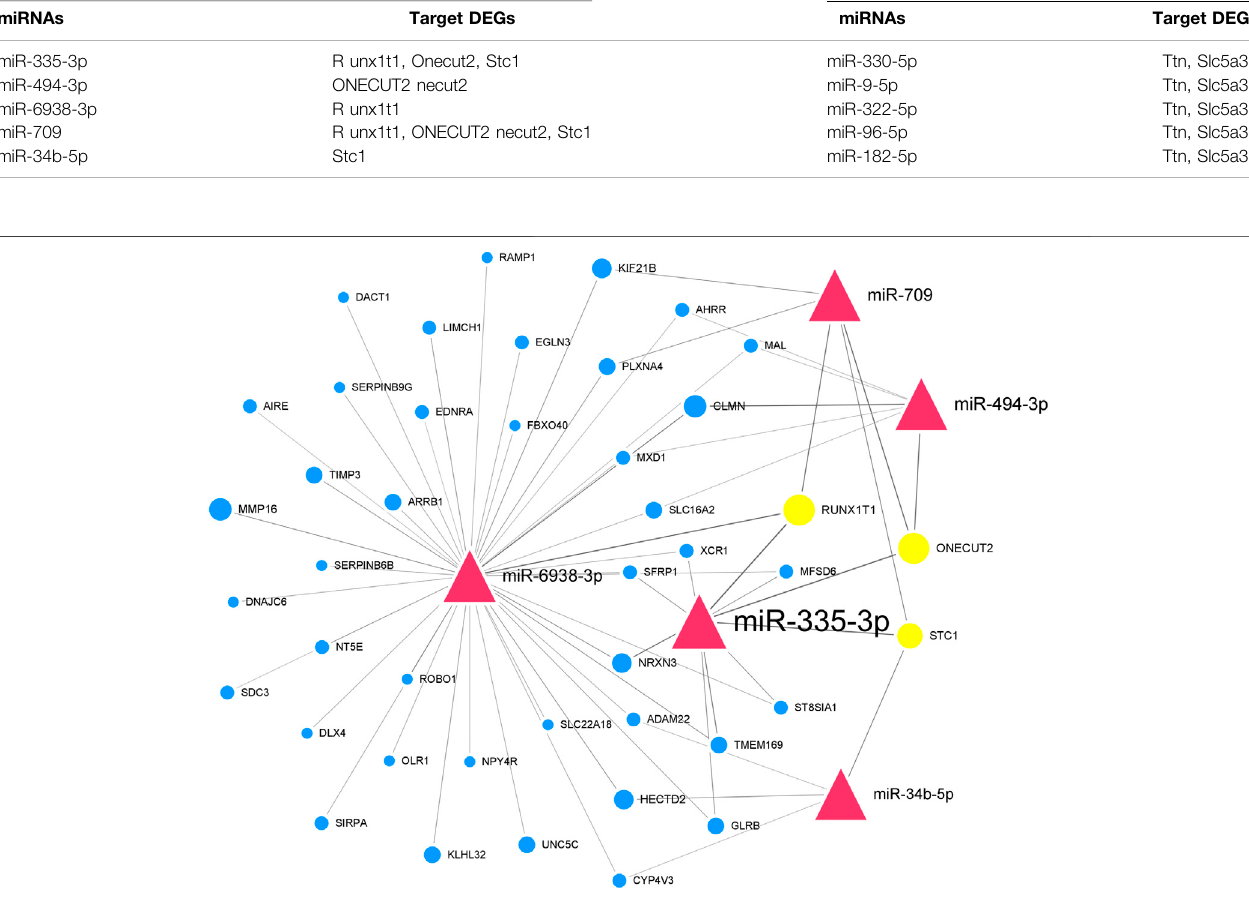
FIGURE 5 | Thu hub upregulated miRNA-downregulated mRNA interaction network in Md fi -OE vs. WT.The network displays the hub miRNA-mRNA interactions. Nodes represent miRNA and mRNA, and edges represent interactions. The upregulated miRNAs are shown in red, downregulated genes are shown in blue, and hub genes are shown in gold. The miRNAs are depicted by triangles and the genes as